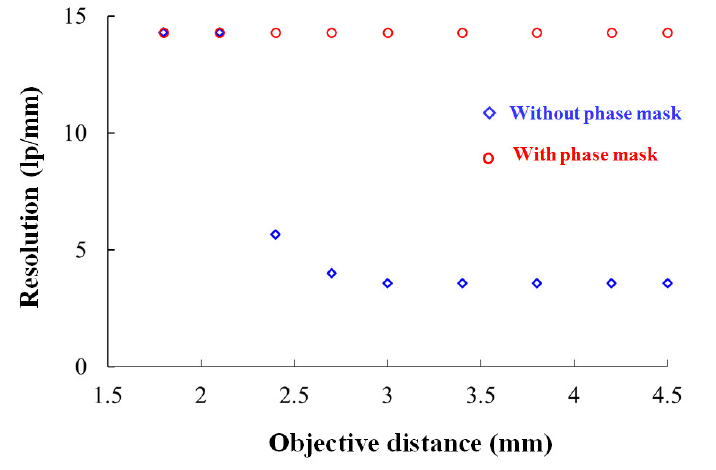
Figure 12. Compared resolution of captured pictures between the optical endoscope without and with phase